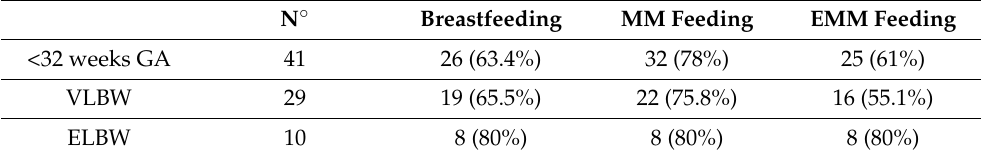
Table 7. Breastfeeding, MM feeding and EMM feeding of the